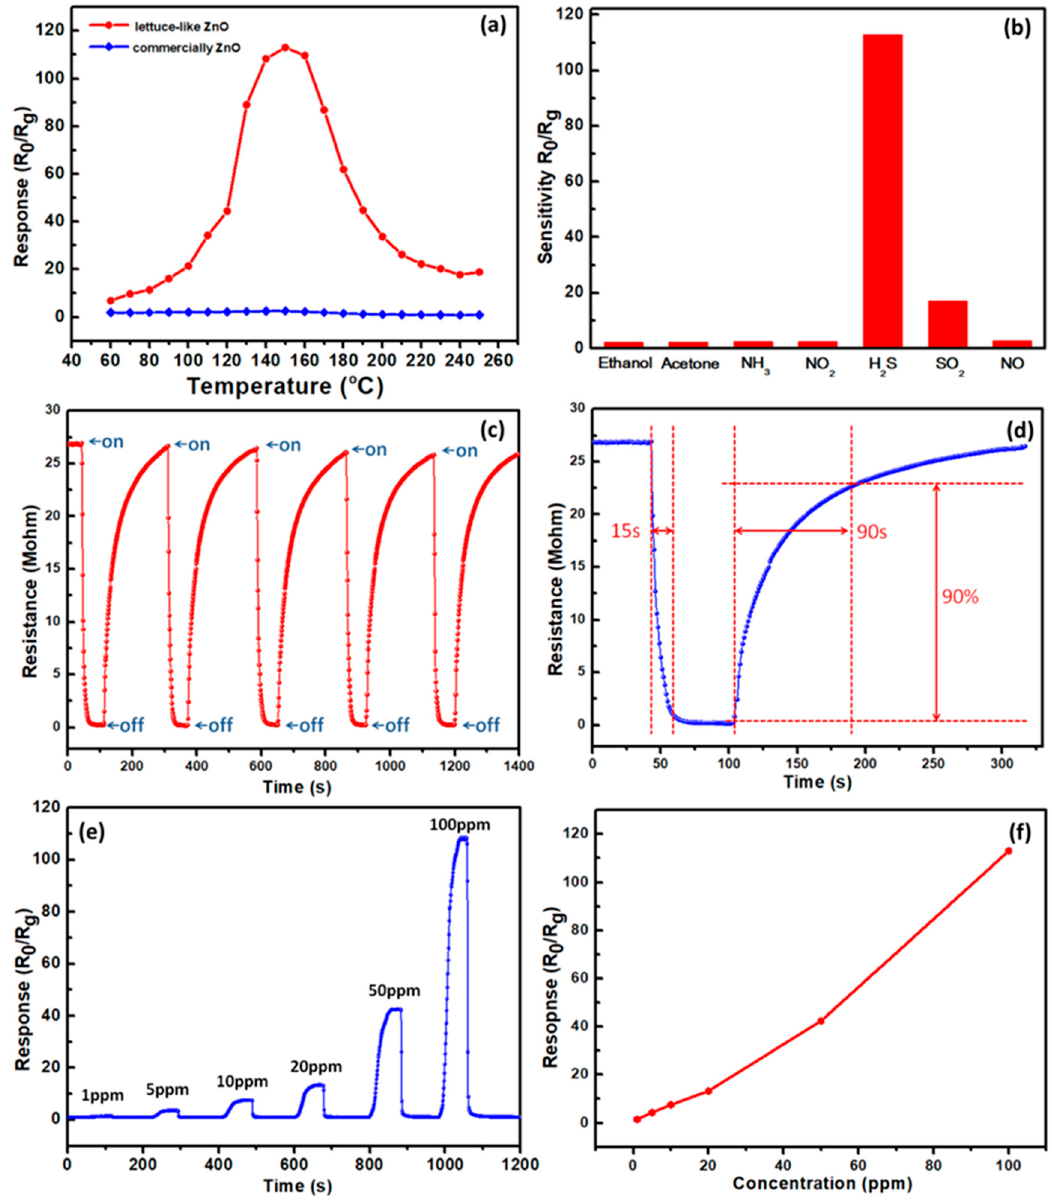
Figure 3. ( a ) Gas sensing response of lettuce-like ZnO sensors and commercial ZnO at different operating temperatures to 100 ppm H 2 S, ( b ) the selectivity of lettuce-like ZnO sensors to 100 ppm different gases, ( c ) the repeatability of lettuce-like ZnO sensors at 150 °C to 100 ppm H 2 S, ( d ) the response and recovery of lettuce-like ZnO sensors to 100 ppm H 2 S, ( e ) the dynamic response of lettuce-like ZnO sensors to 1 − 100 ppm H 2 S at 150 °C, ( f ) the response of lettuce-like ZnO sensors to 1 − 100 ppm H 2 S at 150 °C.